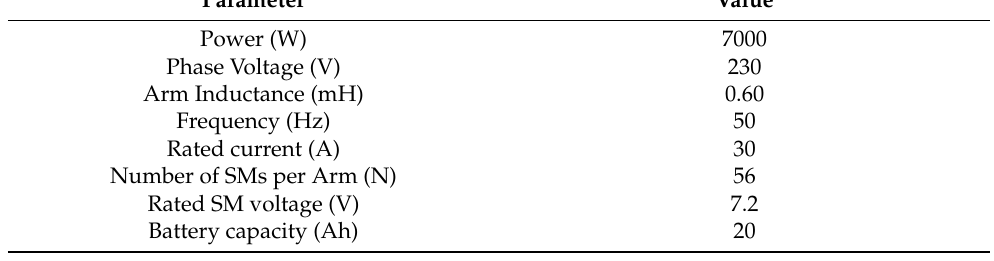
Table 1. Simulation parameters.